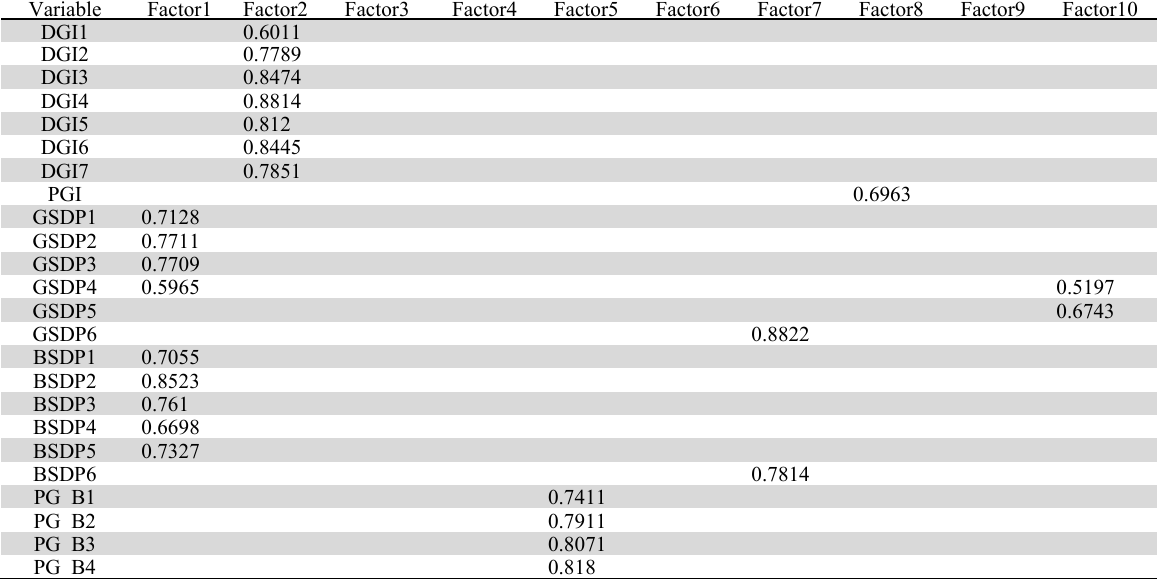
Factor loading of elements that affect green investment (Continued)